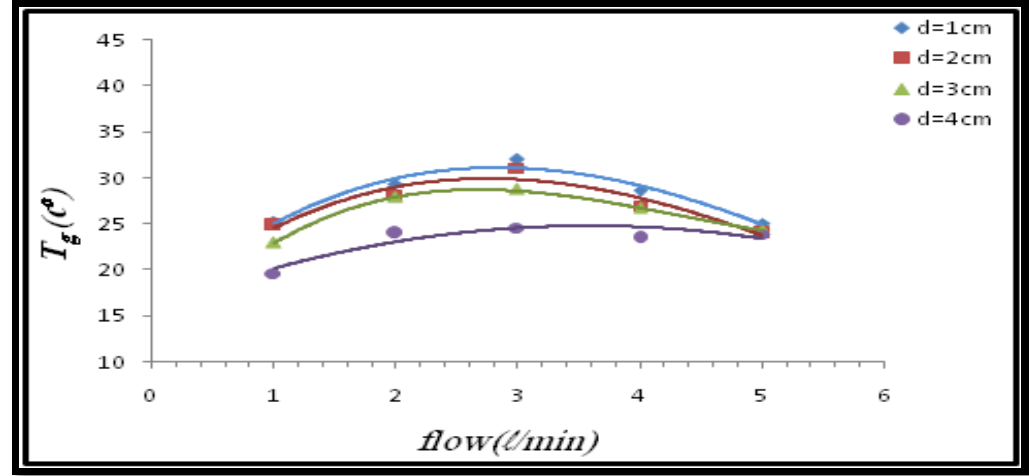
Fig.4: Dependence of the gas temperature on the gas flow rate at various distances